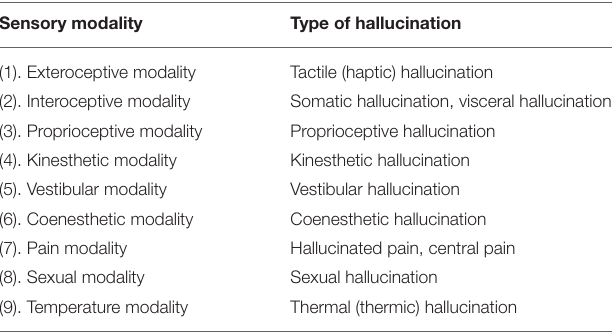
TABLE 1 | Classification of bodily hallucinations and concomitant sensory modalities [from (2)]. Sensory